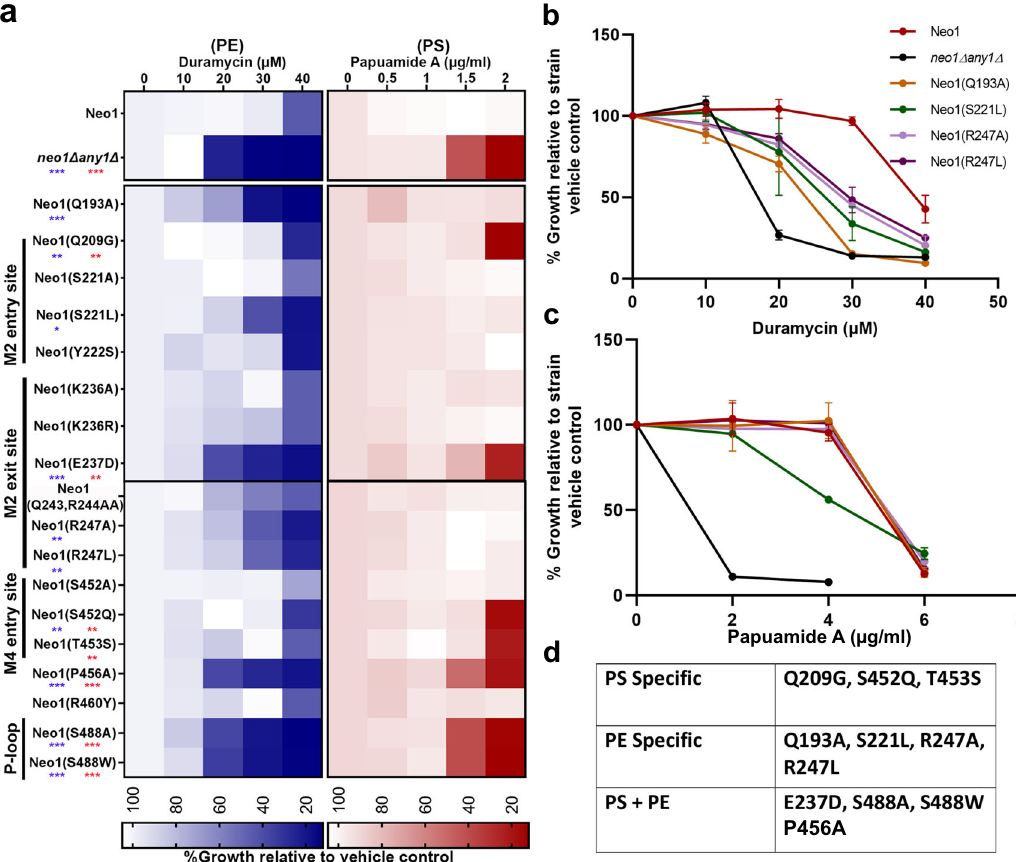
Fig. 5 Neo1 substrate pathway mutations disrupt plasma membrane asymmetry. a Duramycin and papuamide A sensitivity of neo1 Δ strains expressing the indicated Neo1 mutant variants relative to neo1 Δ expressing WT Neo1 and neo1 any1 Δ (a viable strain displaying a complete loss of function for Neo1 ’ s in fl uence on membrane asymmetry). The blue heat map displays duramycin dose responses; growth inhibition at 20 – 30 μ M indicates aberrant exposure of PE. The red heat map displays papuamide A dose responses; growth inhibition at 1.5 – 2 μ g/mL indicates aberrant exposure of PS. The data represents growth relative to WT cells in absence of the drug. Two-way ANOVA was performed to test the variance and comparisons with WT Neo1 were made with Tukey ’ s post hoc analysis ( n = 3, ±standard deviation (SD)). * p < 0.05, ** p < 0.01, *** p < 0.001 (red for papuamide A and blue for duramycin). Neo1 (Y222S) is a gain-of-function mutation that weakly suppresses drs2 Δ 57 . b , c Neo1 mutants hypersensitive to only duramycin in ( a ) were tested at higher d Table summarizing the effects of Neo1 mutations on membrane